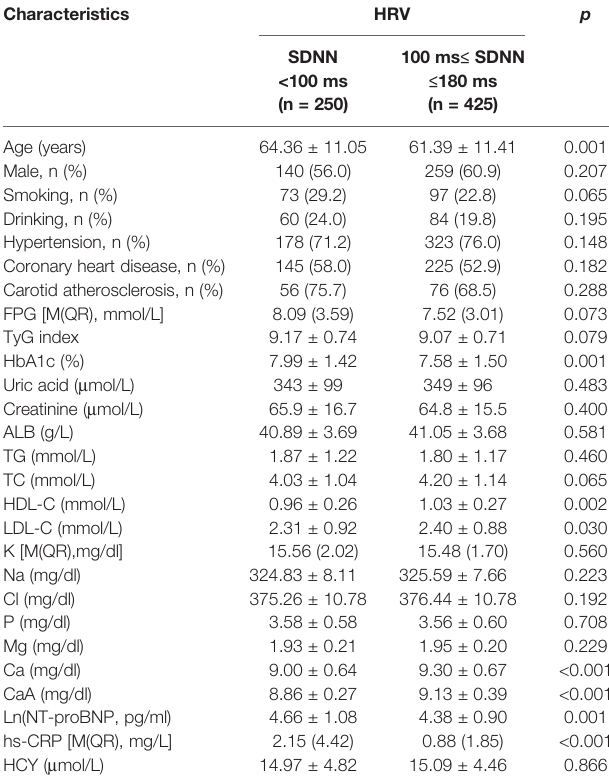
TABLE 1 | Baseline characteristics of subjects categorized by